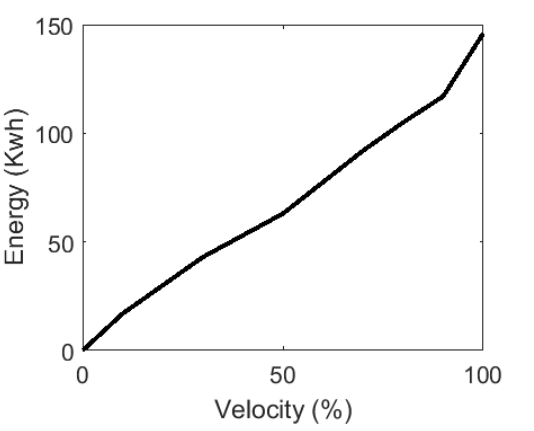
Figure 6. Real change points measured in the Ford Almussafes Factory.